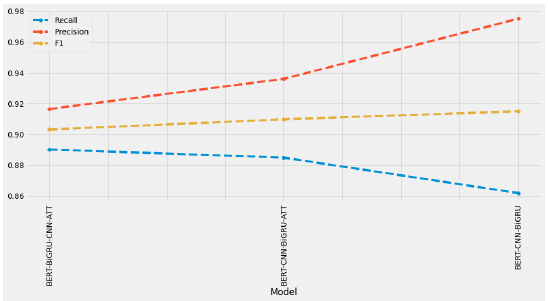
Figure 19. Performance comparisons (%) of models in GossipCop w/o user posting behavior